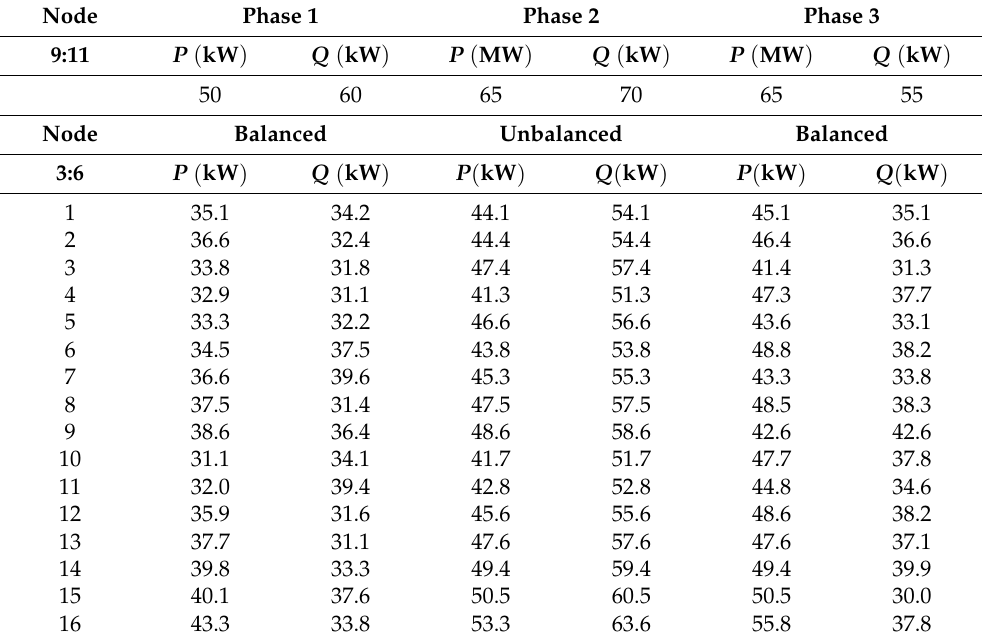
Table 2. Balanced and unbalanced load distributions of all phases.